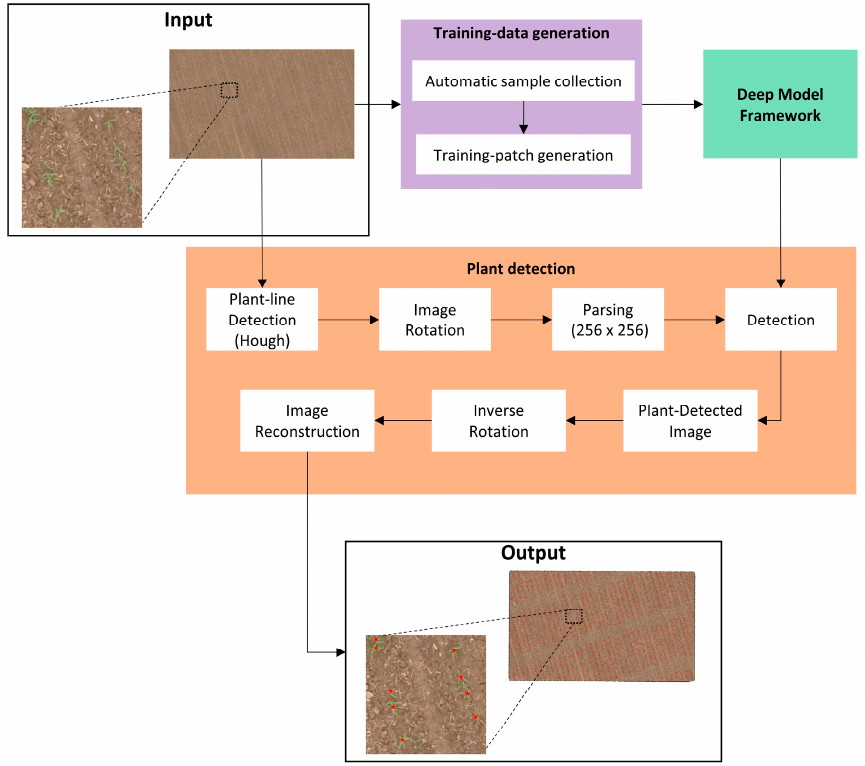
Figure 1. The workflow of the proposed method for automated plant detection.